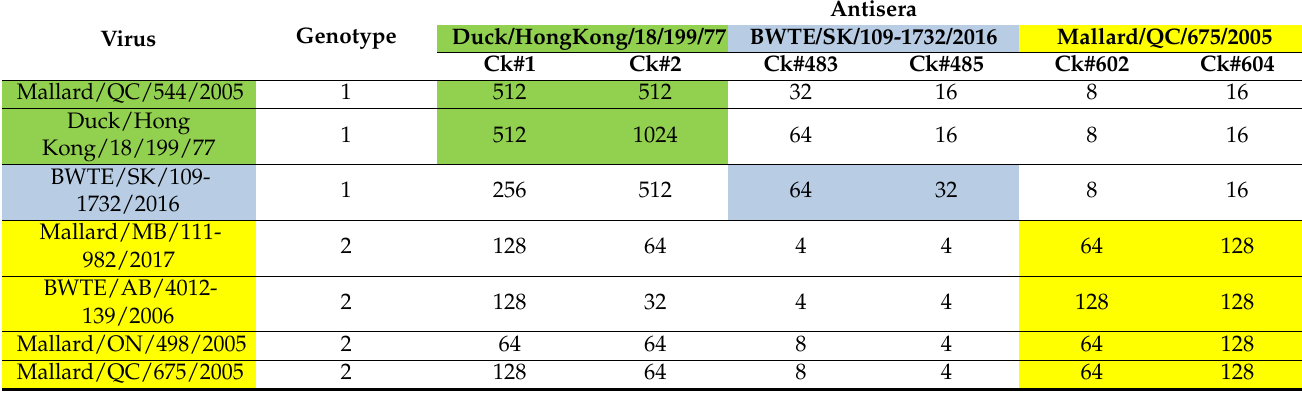
Table 2. Cross hemagglutination inhibition assay test results AAvV-6 strains isolated in Canada from 2005–2016. Same colors indicate homologous titers for each virus and the corresponding antiserum.